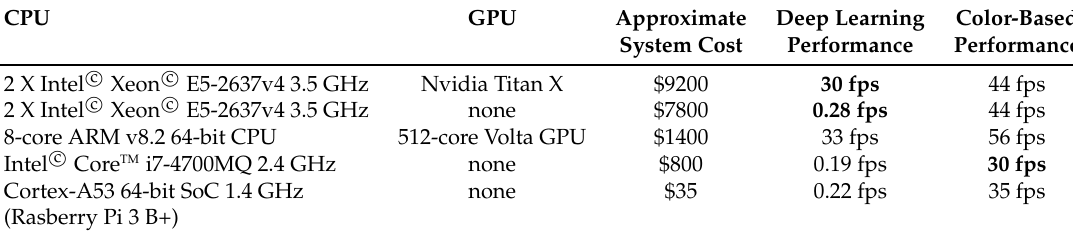
Table 6. Performance estimates for deep-learning and color-based detection algorithms. Performance predictions were extrapolated based on the core-count and clock-speed of target systems relative to measured performance on test systems (denoted in bold). Real world performance may vary due to the various hardware instruction optimization and parallelization capabilities of each platform. Note the color-based algorithm’s ability to provide high frame-rates on low-cost hardware embedded platforms such as the Raspberry